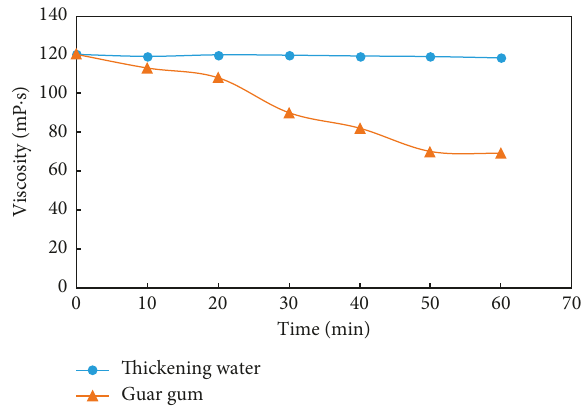
Figure 6: Comparison of viscosity changes with time: two kinds of fracturing fluids.